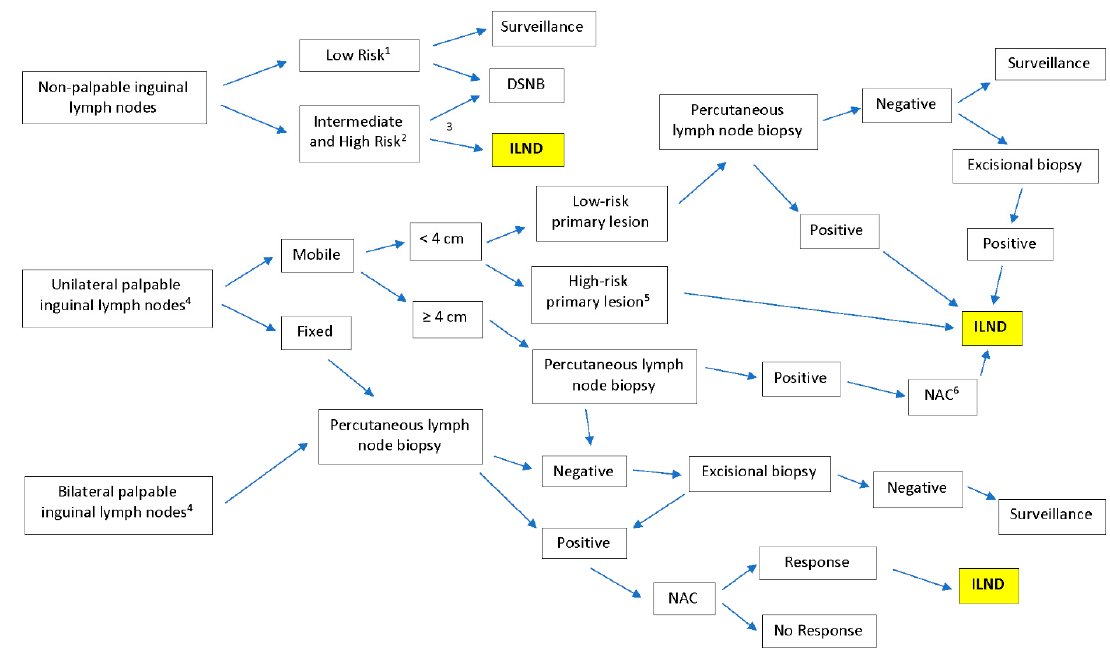
Figure 1. Summary of National Comprehensive Cancer Network (NCCN) guidelines for treatment of penile cancer and the role of inguinal lymph node dissection (ILND). DSNB, dynamic sentinel lymph node biopsy; NAC, neoadjuvant chemotherapy. 1 Tis, Ta, and T1a disease; 2 T1b and T2 or greater disease; 3 Imaging including abdominal / pelvis computed tomography (CT) or magnetic resonance imaging (MRI), with contrast and chest imaging (CT or X-ray); 4 Imaging modalities include abdominal / pelvis CT or MRI, with contrast and chest imaging (CT or X-ray) for palpable lesions which provide information that guides therapeutic steps shown in the figure; 5 T1, high-grade, lymphovascular invasion, > 50% poorly di ff erentiated; 6 Patients ineligible for cisplatin-based chemotherapy can move straight to ILND. ILND was highlighted for the purpose of bringing attention to the procedure, as it is a complex